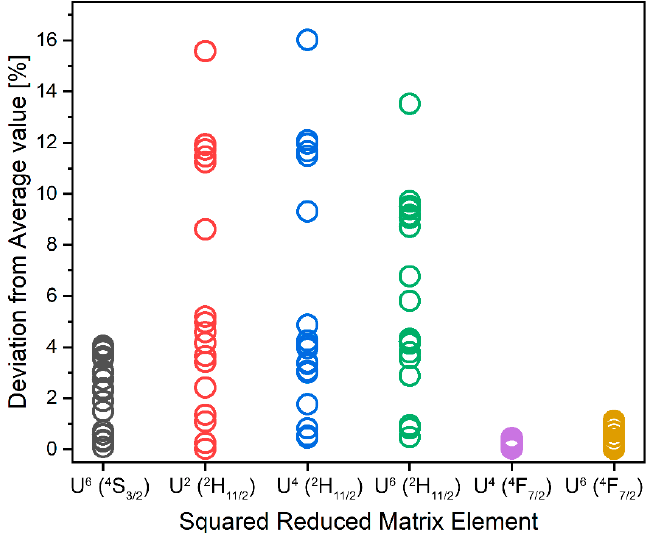
Figure 4. Deviation of the RMEs listed in Table 3 from their average values. Table 4. Average RME values estimated from squared RMEs listed in Table 3. Deviations of aver- age values from squared RMEs reported by Carnall (C) and Weber (W), in percentage.